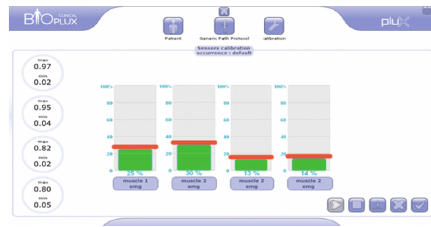
Figure 1: Terminal healthcare bioPLUX (MCT) [8].